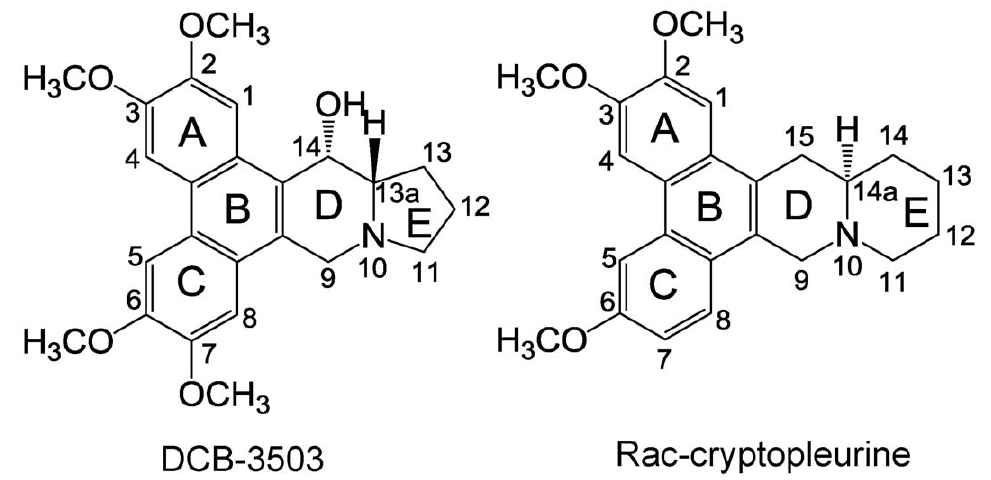
Figure 1. The chemical structures of DCB-3503 and Rac-cryptopleurine.